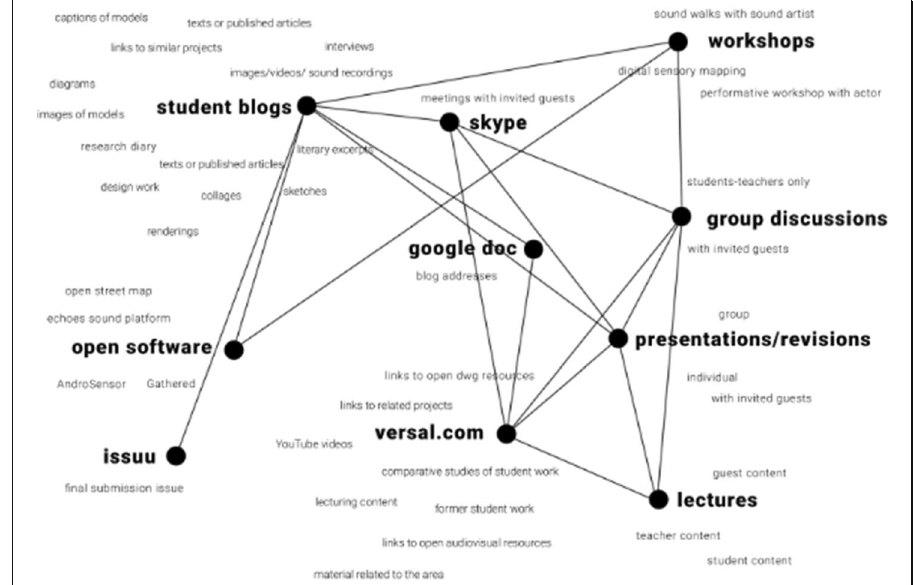
Fig. 2 Map of the interdependencies between online and f2f learning